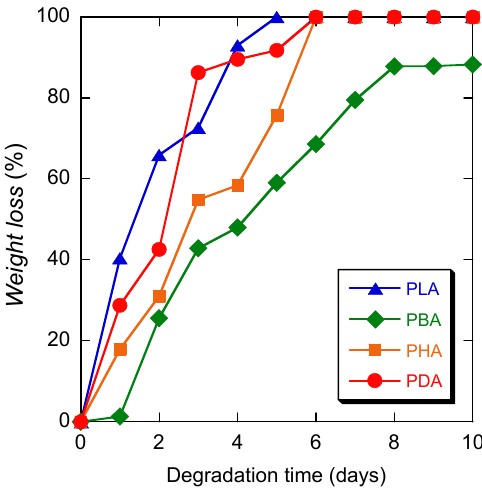
Figure 4. Weight loss of PLA, PBA, PHA, and PDA during hydrolytic degradation at 80 °C, as a function of degradation